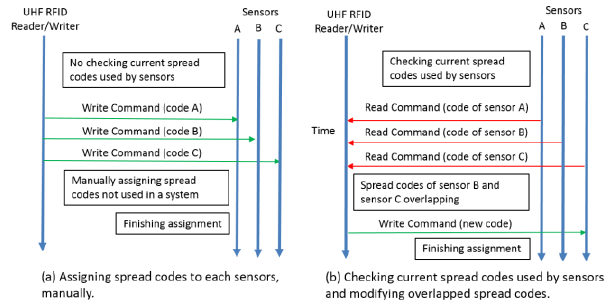
Figure 4. Structure of (a) Assigning spread codes to each sensors, manually and (b) Checking current spread codes used by sensors and modifying overlapped spread codes.